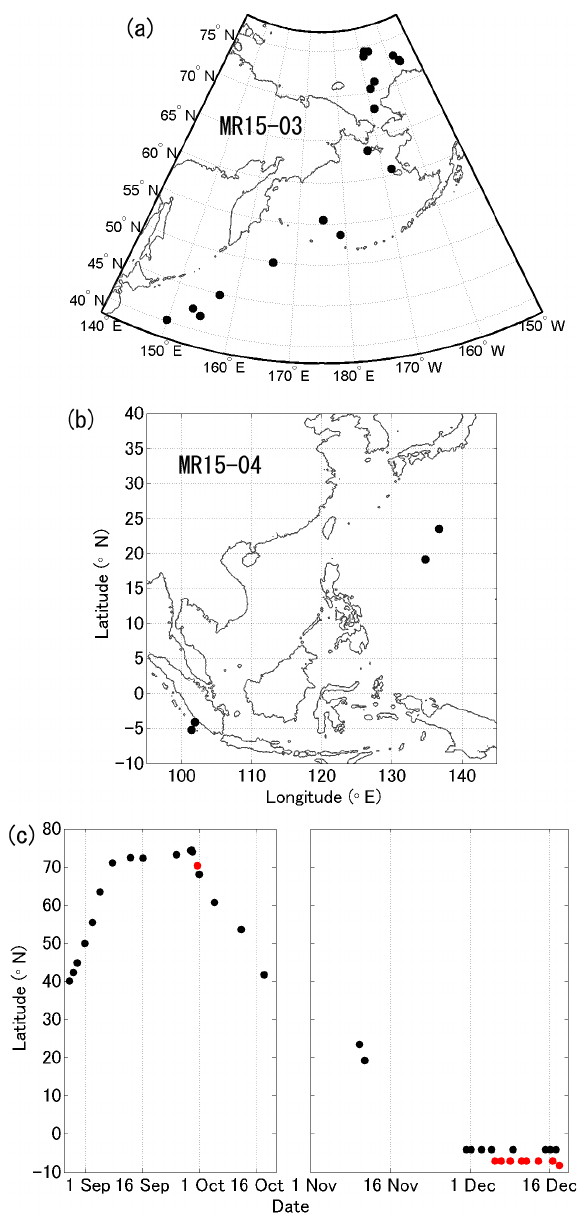
Figure 1. Positions of the twin-radiosonde launches during the (a) MR15-03 cruise and (b) MR15-04 cruise. (c) Time–latitude di- agram of the launches. Black and red dots represent daytime and nighttime soundings, respectively. The red dots in December are plotted with a shift of 3 ◦